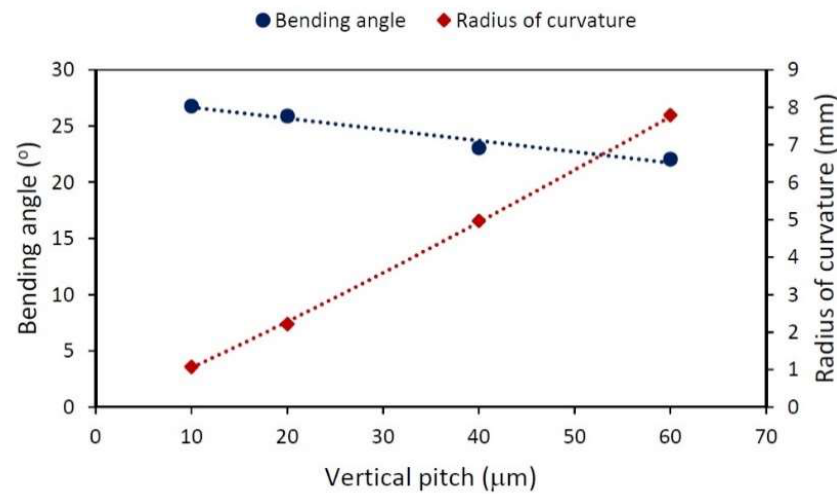
Figure 6. Bending angle (round points) and radius of curvature (diamonds) dependence on vertical pitch ranging from 10 to 60 µ m. The length of the treated area ranged accordingly from 0.5 to 3 mm, while E = 111 µ J, P x = 1 µ m, f = 1 kHz and v = 1 mm . The lines are visual guides. s